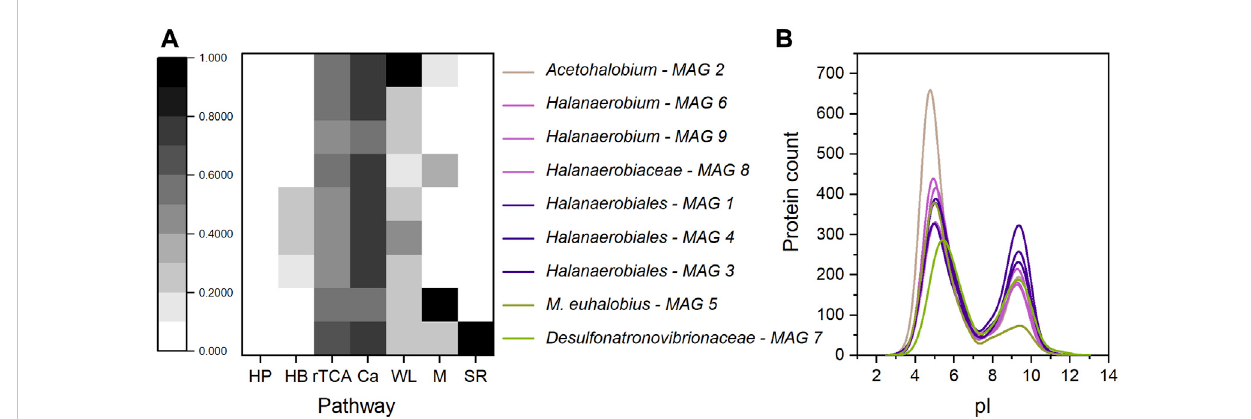
FIGURE 3 (A) Pathwaycompleteness(representedthroughdifferentshades ofgrey)ofnine MAGs obtained throughmetagenome sequencingof samplesS11, S14, S12 and S15. HP - 3-Hydroxypropionate bi-cycle; HB – Hydroxypropionate-hydroxybutyrate cycle; rTCA – reverse citric acid cycle; Ca – Calvin cycle; WL - Wood-Ljungdahl pathway; M – methanogenesis; SR – sulfate reduction; (B) Distribution of the protein isoelectric point (pI), obtained after MAG annotation using DRAM. The pI value was calculated using the expasy pI calculator plugin for RStudio. Violet: all members of Halanaerobiales , olive: Methanohalophiluseuhalobius andgreen: Desulfonatronovibrionaceae sp.MeanpI-Value:MAG1 – 6.7;MAG2 – 6.1;MAG3 – 6.9;MAG4 – 7.0;MAG5 –